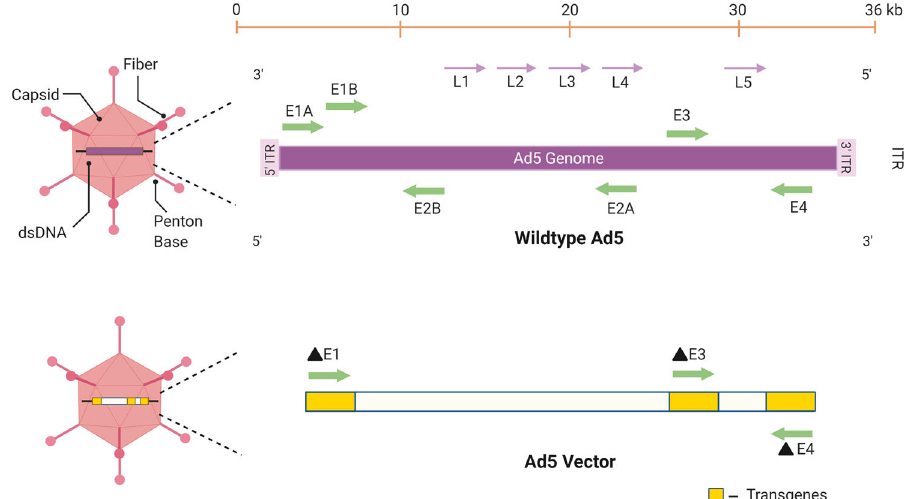
Fig. 1 Schematic representation of the Adenovirus 5 linear genome and an Ad5 vector. The adenovirus genome is characterized by inverted terminal repeats (ITR) and several early (E) and late (L) genes. The early genes are responsible for modifying host gene expression to allow for viral protein synthesis and replication. The late genes allow for viral packaging and release. Replication-competent adenoviral vectors contain an intact E1 region and the transgene of choice in the E3 region. Typically, replication-defective adenoviral vectors contain a partial or complete deletion of the E1 region and contain a transgene in either the E1 or E3 region. Deletion of the E4 region may also allow for the insertion of a larger foreign